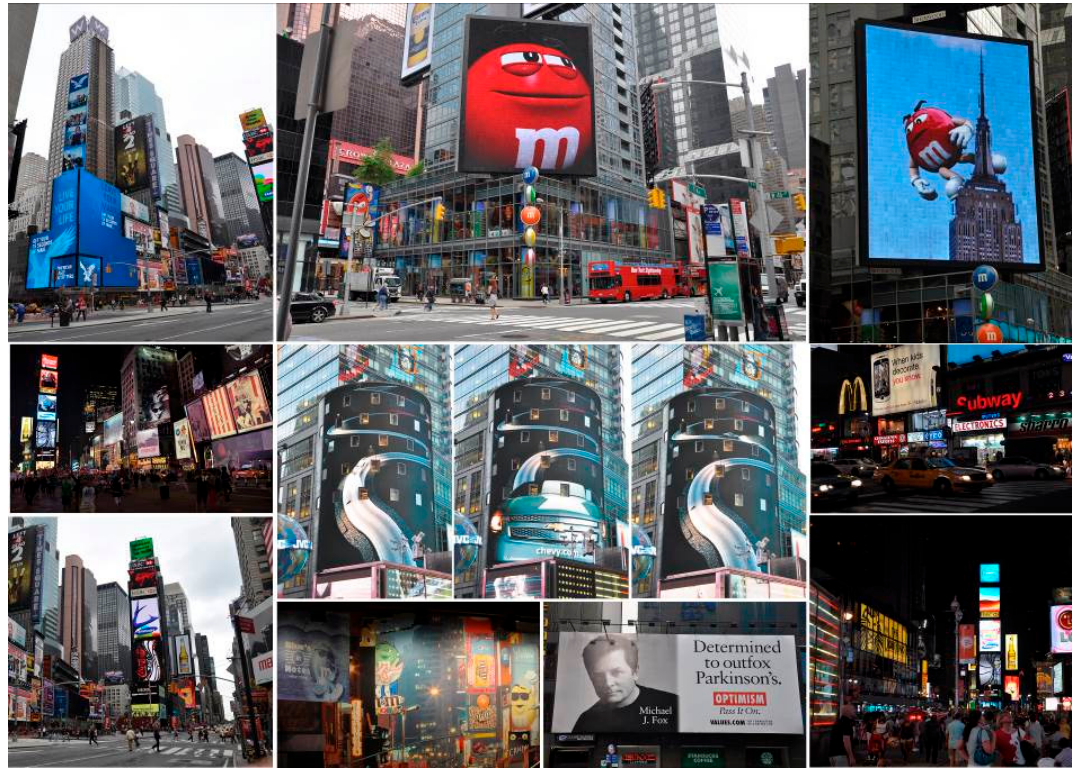
Figure 8. Some images of Times Square in New York. In the center NASDAQ curved